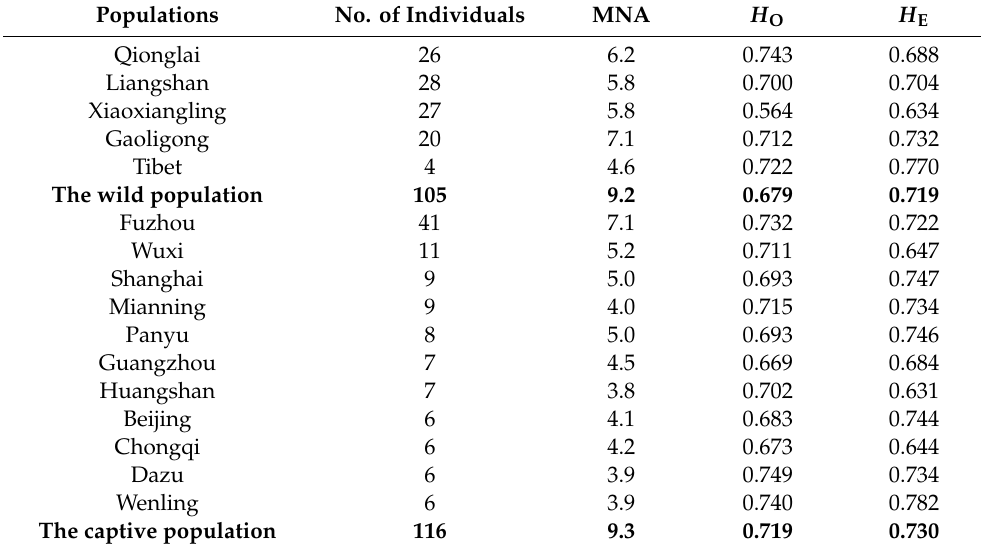
Table 4. The comparison of genetic diversity from captive populations and wild populations of red panda. The bold indicates the sum of the above numbers. Populations No. of